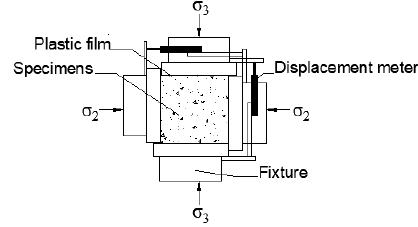
Figure 3. The biaxial loading pattern.